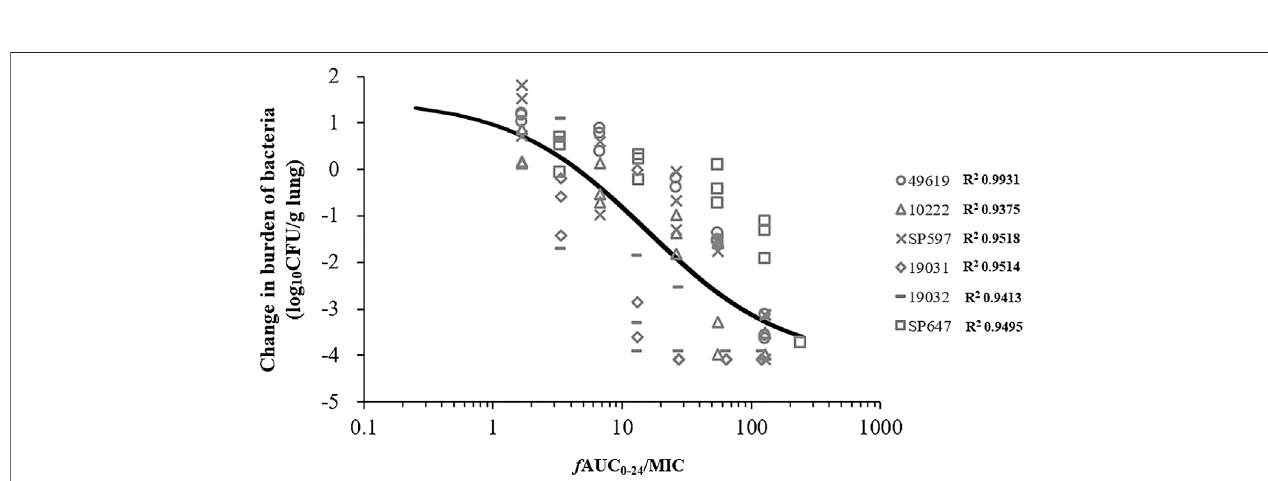
FIGURE 4 | Correlation between PK/PD index f AUC 0-24 /MIC and ef fi cacy of nemonoxacin against pooled data of six Streptococcus pneumoniae strains using a neutropenic murine lung infection model in dose-escalation experiment. Treatment was initiated at 2 h postinfection. Nemonoxacin was subcutaneously administered with single dose range of 1.25 – 160 mg/kg. Each point represents data for each mouse. R 2 , square of the correlation coef fi cient.